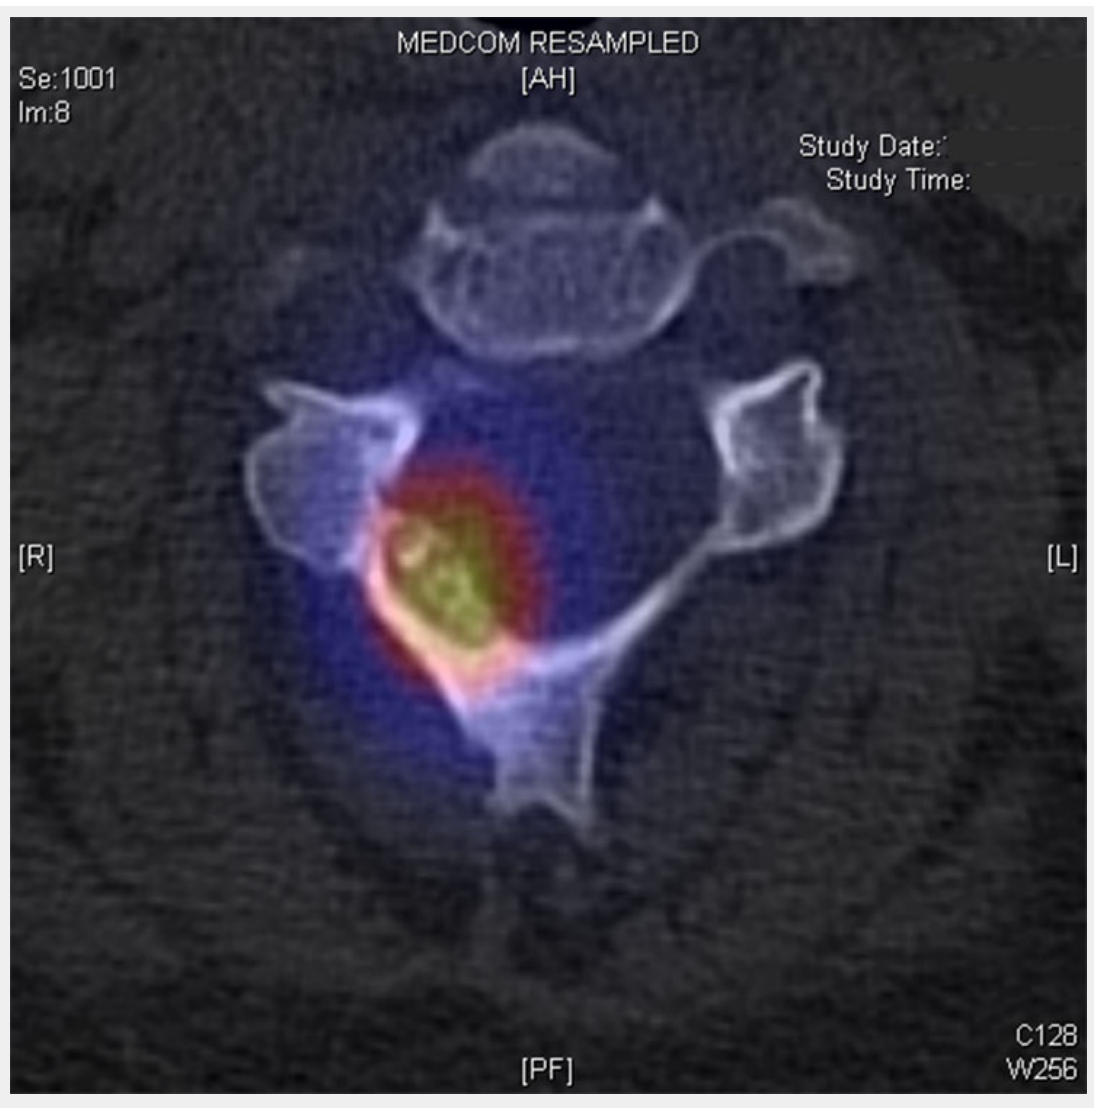
Figure 5 ( B ) revealed an osteoidosteoma in the right lamina of C4. Partial laminectomy led to immediate pain relief ( C